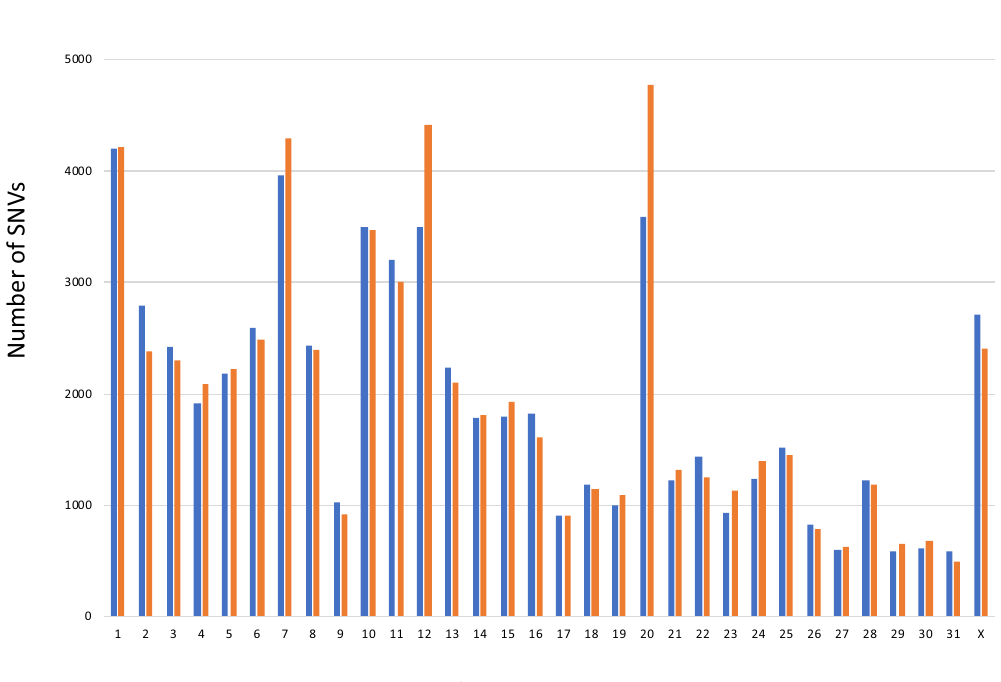
Figure 2. Distributions of synonymous and non-synonymous substitutions detected in gene-coding regions. Blue: synonymous; orange: